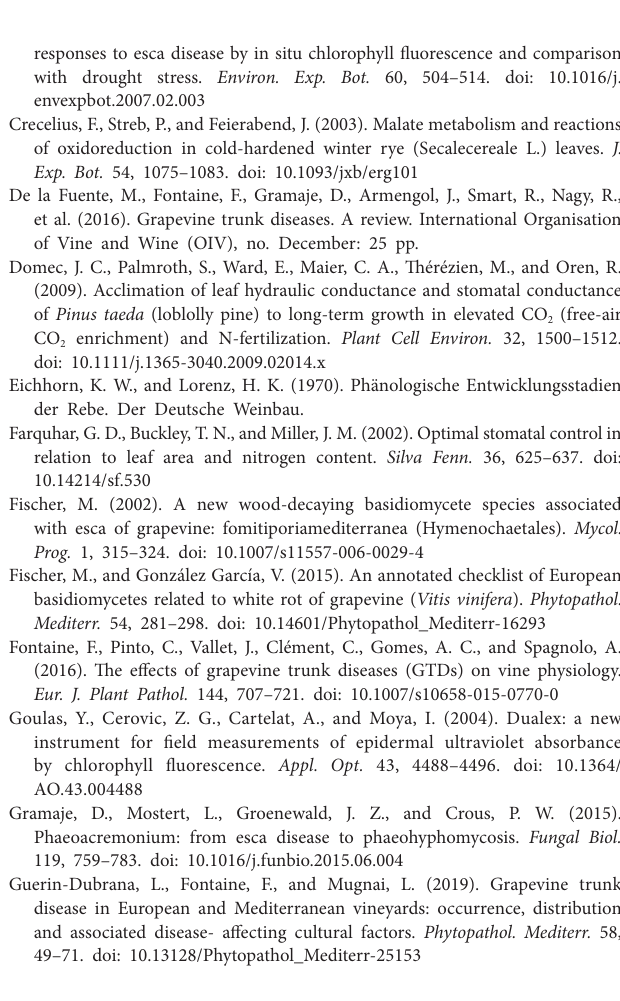
Supplementary Figure S1 | Evolution of leaf area index (LAI in m 2 of leaves per m 2 of ground) in asymptomatic and symptomatic grapevines during the 2017 and 2018 growing seasons. Large symbols in the middle of each panel represent overall stand means (± SE) of asymptomatic and symptomatic grapevines. Supplementary Figure S2 | Evolution of sap flow in asymptomatic and symptomatic grapevines under different climatic conditions. (A) Diurnal courses of sap flow in asymptomatic and symptomatic grapevines recorded in 2017 (right) and 2018 (left). (B) Evolution of temperature and vapor-pressure deficit (VPD) conditions in 2017 (right) and 2018 (left). Error bars in panel (A) represent